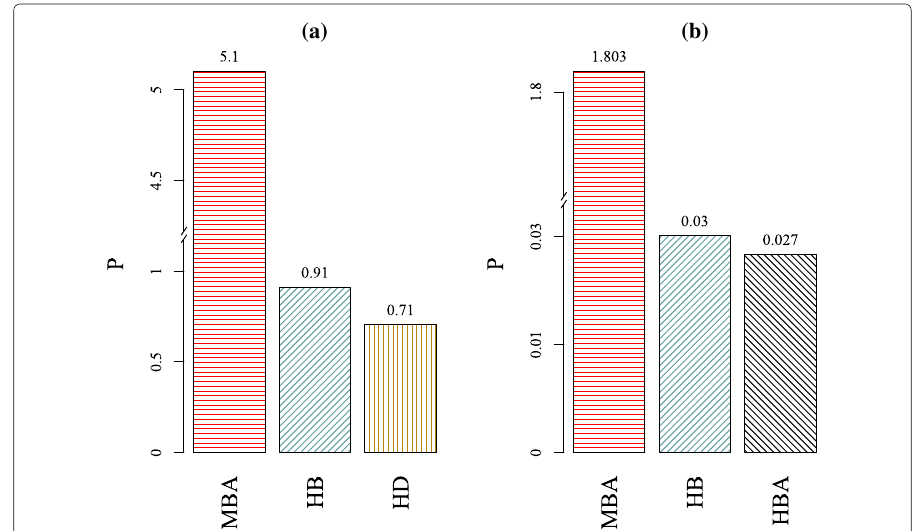
Fig. 6 The histograms show the performance of the three best attacks on the federal criminal intelligence network. a shows Module-Based (MBA - horizontal red shades), High Betweenness (HB - inclined blue shades) and High Degree (HD - vertical golden shades) strategies for node removal, while b depicts MBA, HB and High Betweenness Adaptive (HBA - inclined black shades) methods for edge-based removal